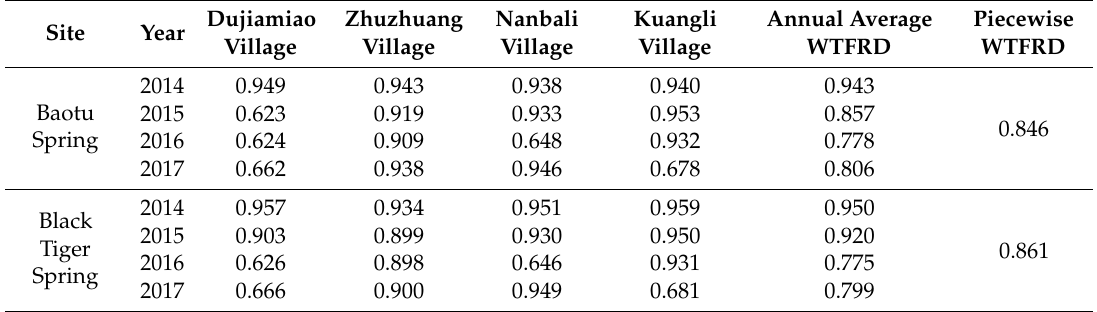
Table 8. WTFRD between Western Jinan and Jinan spring groups from December to March of next